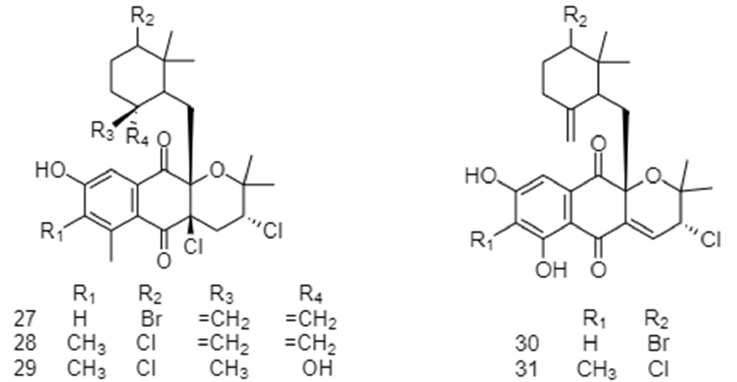
Figure 17. Chemical structures of napyradiomycins isolated from marine ‐ derived S. aculeolatus strains PTM ‐ 029 [142]. Gopikrishnan et al. (2019) [145], reported the isolation, characterization, and poten ‐ tial antifouling activity of taxifolin (32), a flavonoid compound from Streptomyces sp.